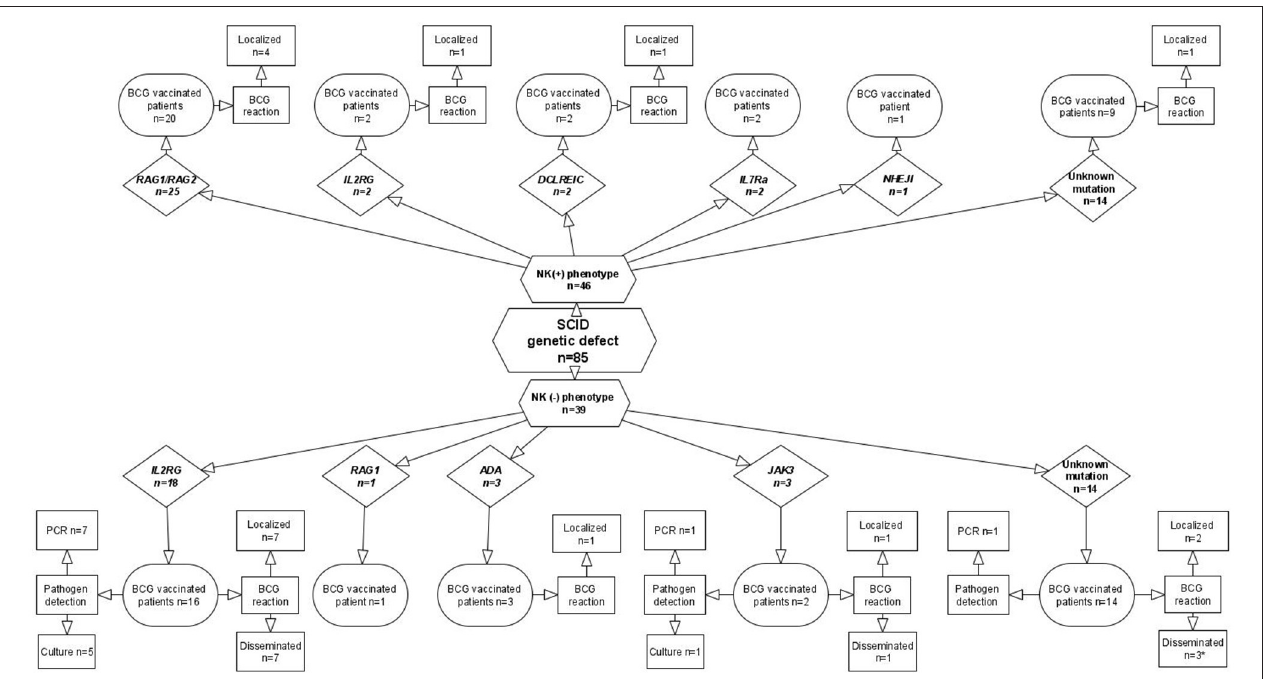
FIGURE 1 | SCID diagnosis and BCG-associated complications in patients hospitalized at CMHI.